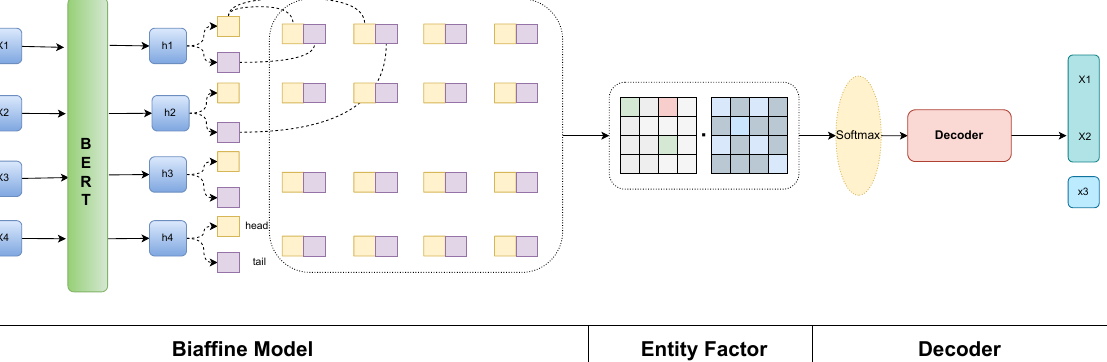
Figure 3. Architecture diagram of the model. After the initial score matrix is given by the biaffine model, the final score matrix is acquired by incorporating the entity factors, and the decoder decodes the entity and relation labels depending on the final